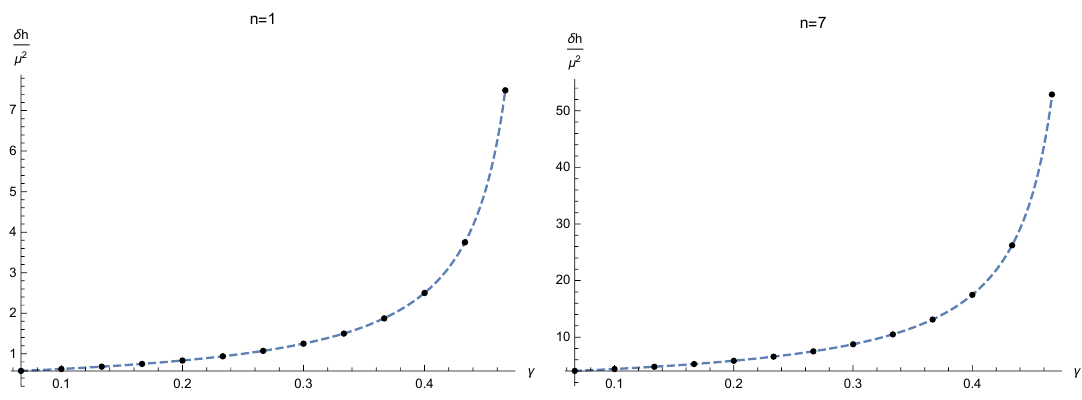
Figure 3 . The order µ 2 anomalous weight δh extrapolated to infinite level k at fixed γ = j 0 dots), compared to that of the known pp-wave string spectrum (4.40) (dashed blue curve), at two sample values of the oscillator level n